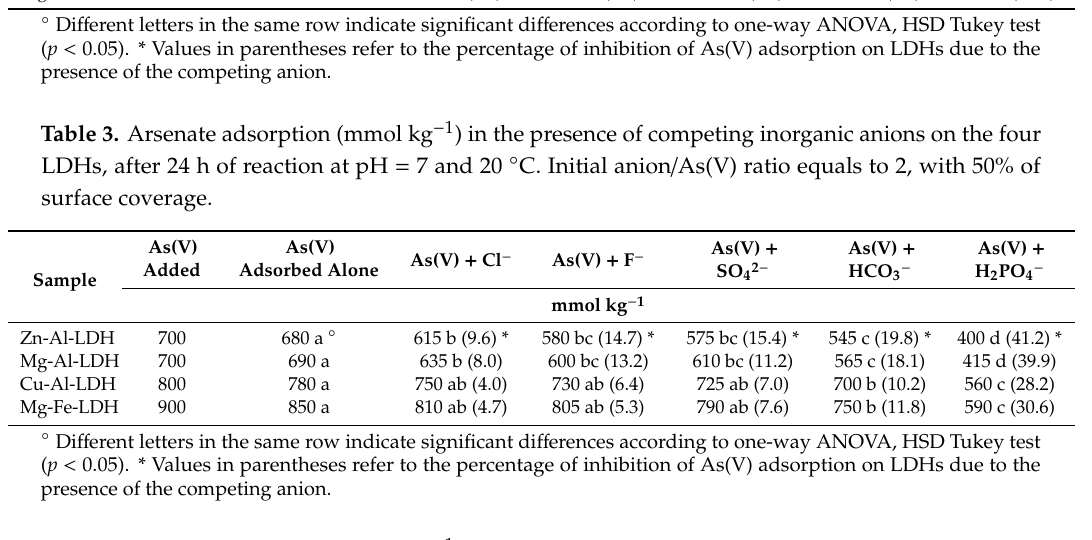
Table 4. Arsenate adsorption (mmol kg − 1 ) in the presence of competing inorganic anions on the four LDHs, after 24 h of reaction at pH = 7 and 20 ◦ C. Initial anion / As(V) ratio equals to 3, with 50% of surface